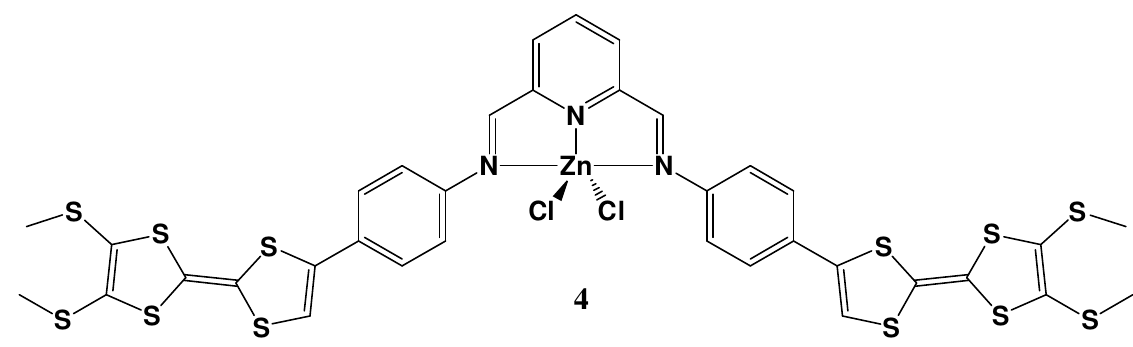
Figure 2. Schematic drawing of the zinc metal complex ( 4 ).